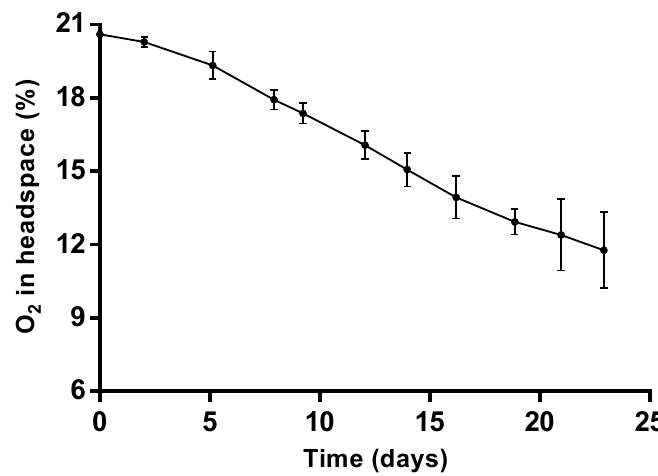
Figure 6. Oxygen in headspace analysis for the L-NPs system.